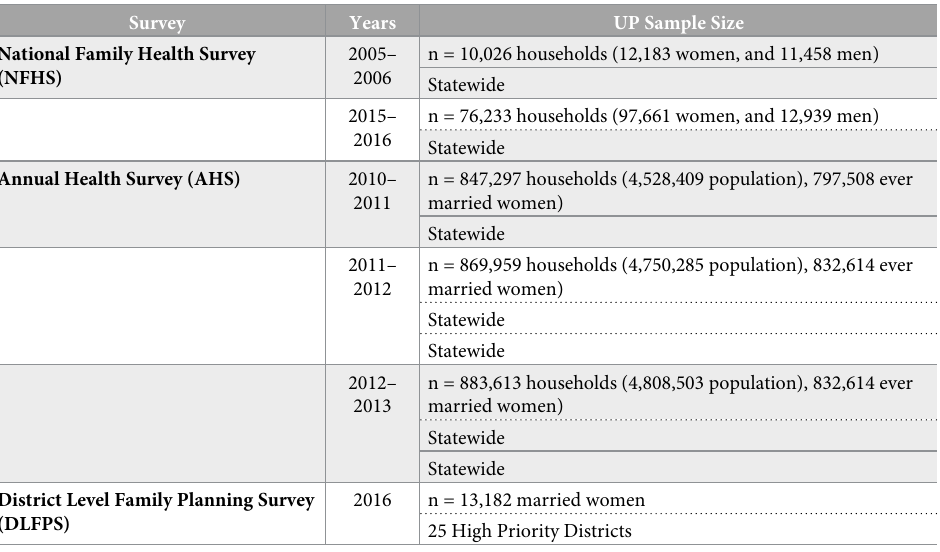
Table 1. Quantitative survey Uttar Pradesh sample